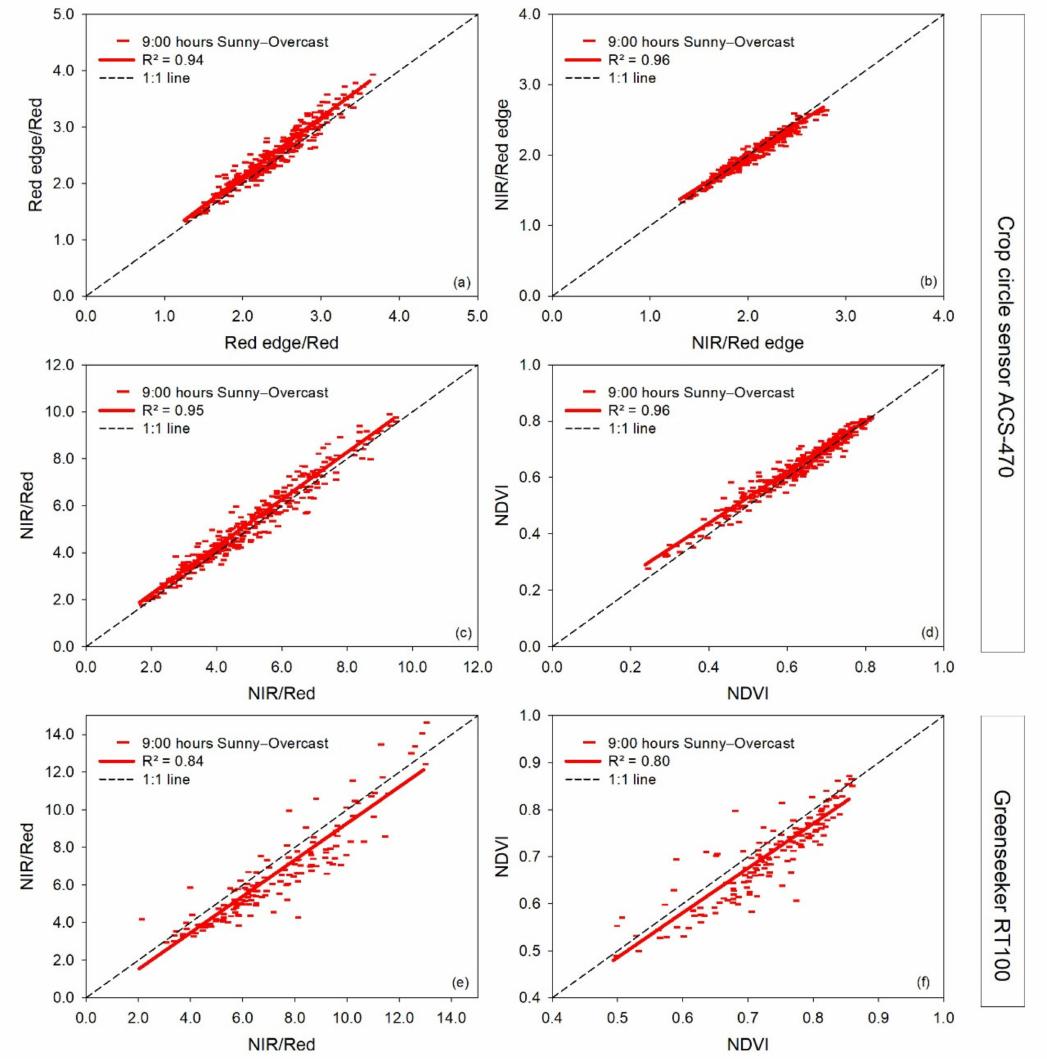
Figure 6. Linear regressions between paired measurement times at 9:00 h in a sunny (independent variable) (08-05-2019) and overcast (dependent variable) (07-05-2019) day for each vegetation index measured with two active vehicle-carried sensors, Crop Circle ACS-470 and Greenseeker RT100. R 2 : coefficient of determination. The dashed line represents the 1:1 line. In the pairwise comparison, the sunny day’s information is indicated on the x-axis and for the overcast day on the y-axis ( a – f